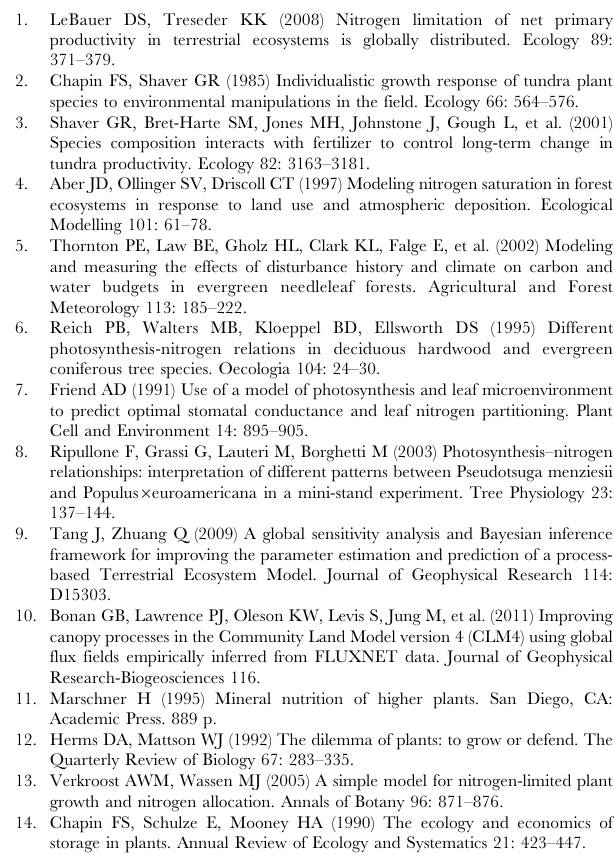
Table S1 Main model